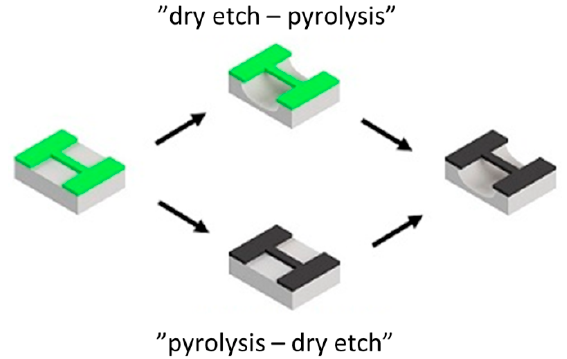
Figure 1. Two fabrication strategies for pyrolyzed photoresist microresonators. In the schematic grey is the Si substrate, green is the photoresist and black is the carbon.